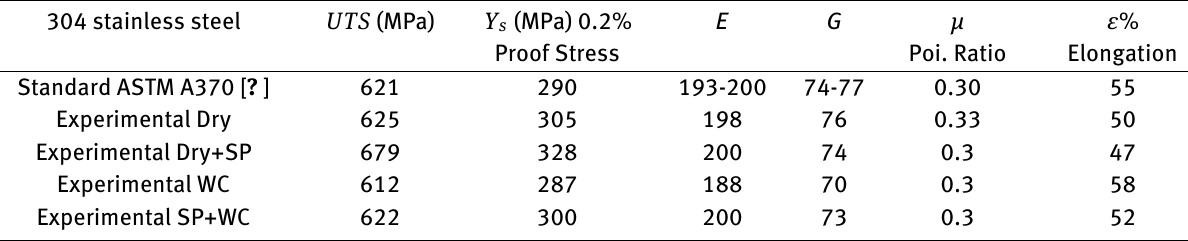
Table 2: The experimental and standard mechanical properties of stainless steel 304 304 stainless